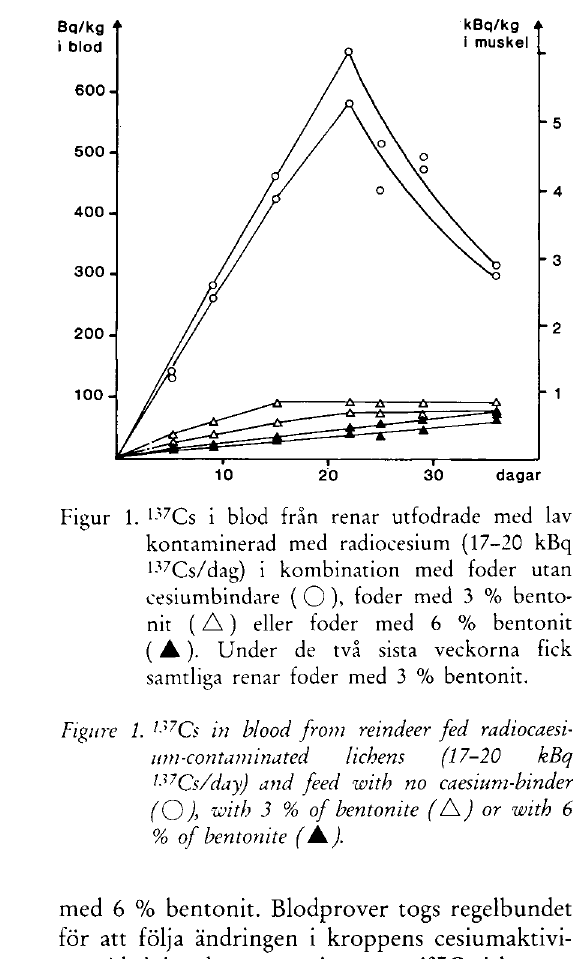
Figure 1. L ' 7 Cs in blood from reindeer fed radiocaesi- um-contaminated lichens (17-20 kBq l -" 7 Cs/day) and feed with no caesium-binder (O), with 3 % of bentonite (A) or with 6 % of bentonite